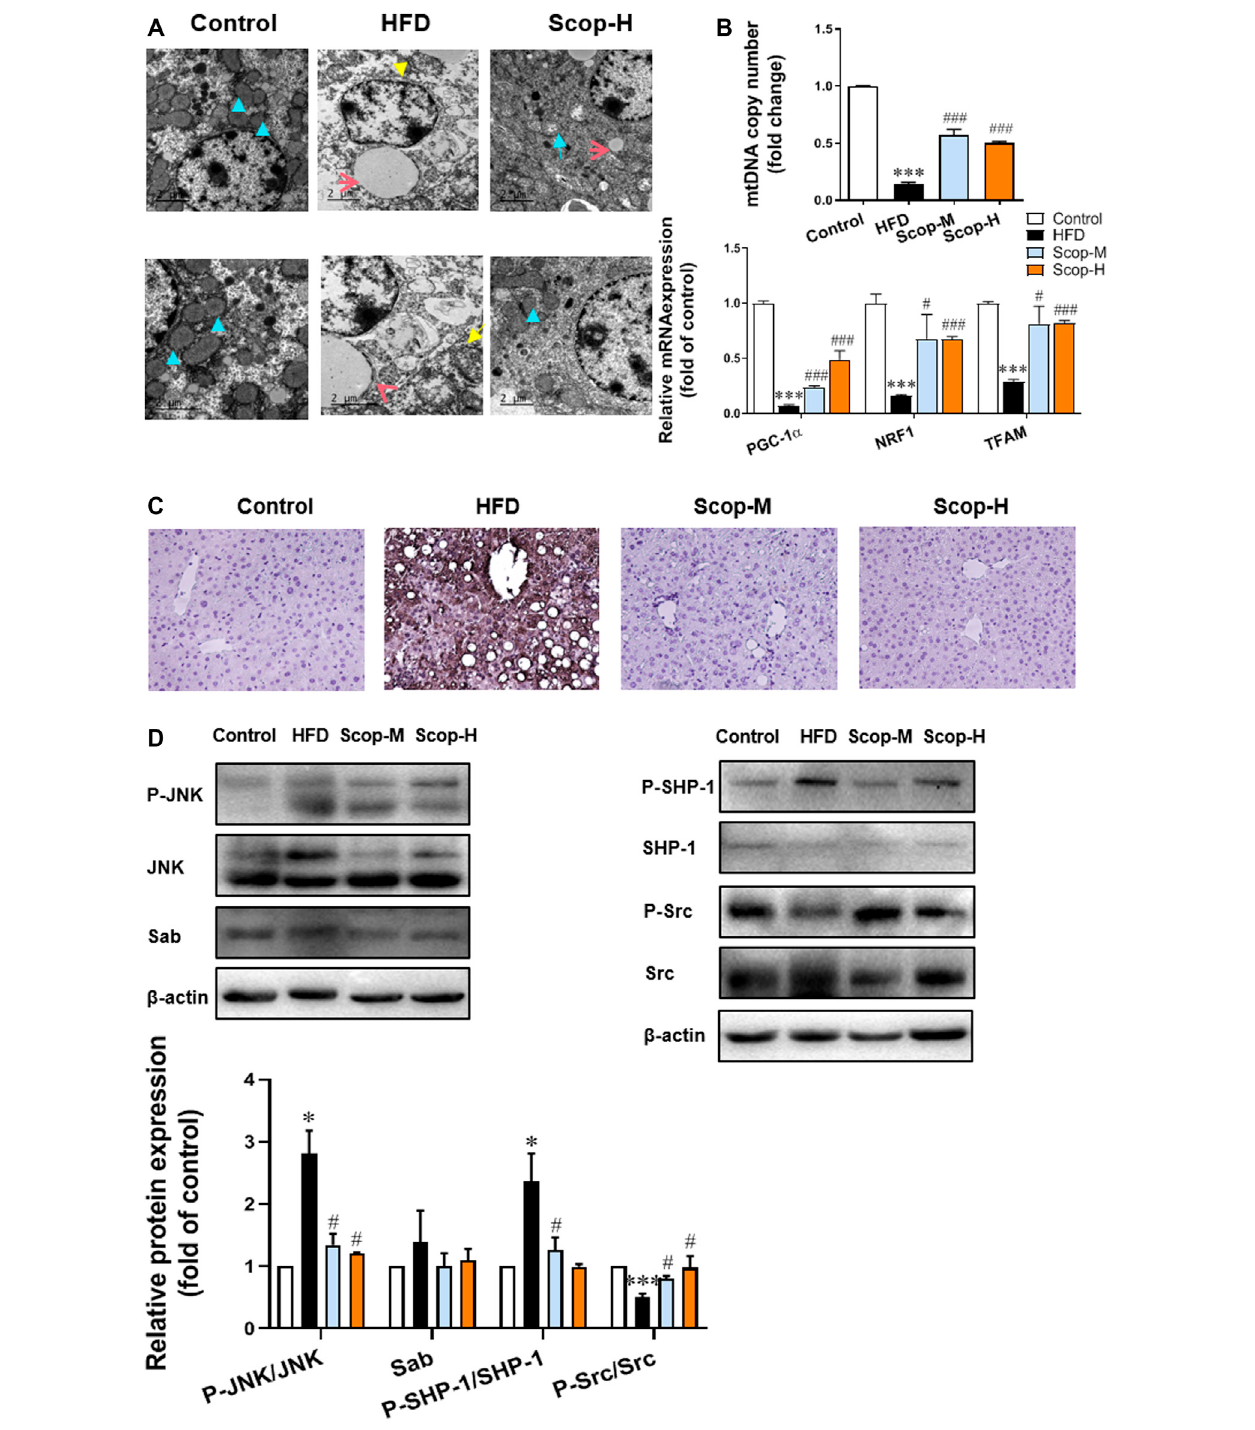
FIGURE 8 | Scoparone inhibited the JNK/Sab signaling pathway and improved mitochondrial dysfunction in the liver tissues of NASH mice. (A) Electron microscope images ofthe mouse liver tissues (blue arrow: normal mitochondria, yellow arrow: mitochondrial cavitation, red arrow: lipid droplets) (200,00×). (B) PGC-1 α proteinexpression inmouse livertissues. (C) IHC stainingof4-HNEinmouse livertissues (200×). (D) Theexpression and/or activationlevel ofJNK/Sab signaling-related protein. *** p < 0.001 vs. Control; # p < 0.05 , ### p < 0.001 vs. Model.